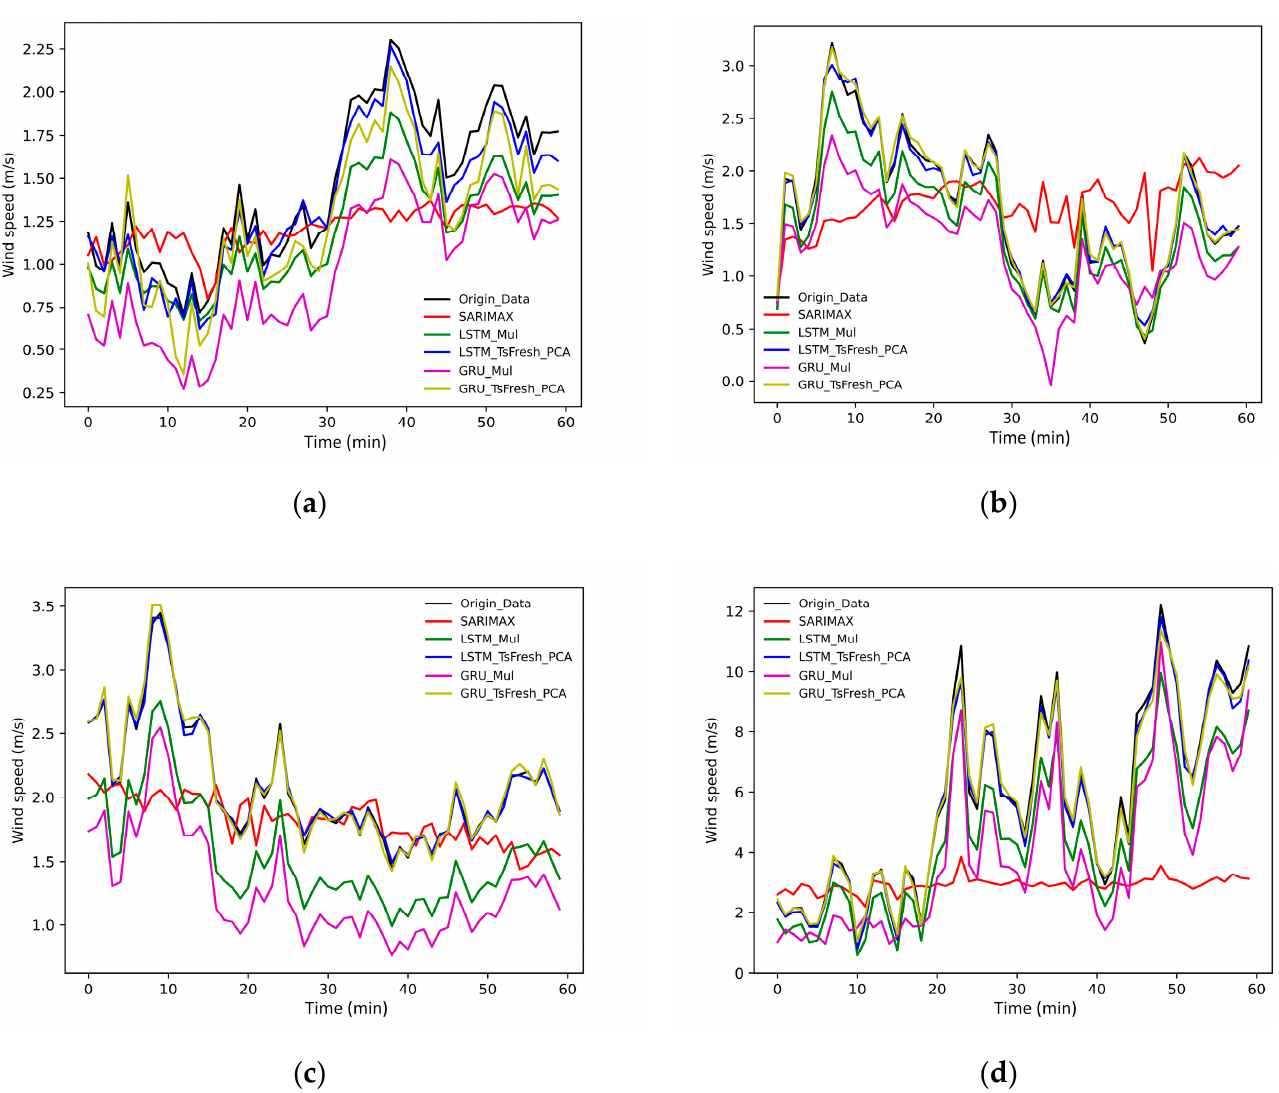
Figure 10. Prediction results of five models. ( a ) Five model predictions for the spring dataset; ( b ) five model predictions for the summer dataset; ( c ) five model predictions for the autumn dataset; ( d ) five model predictions for the winter dataset.